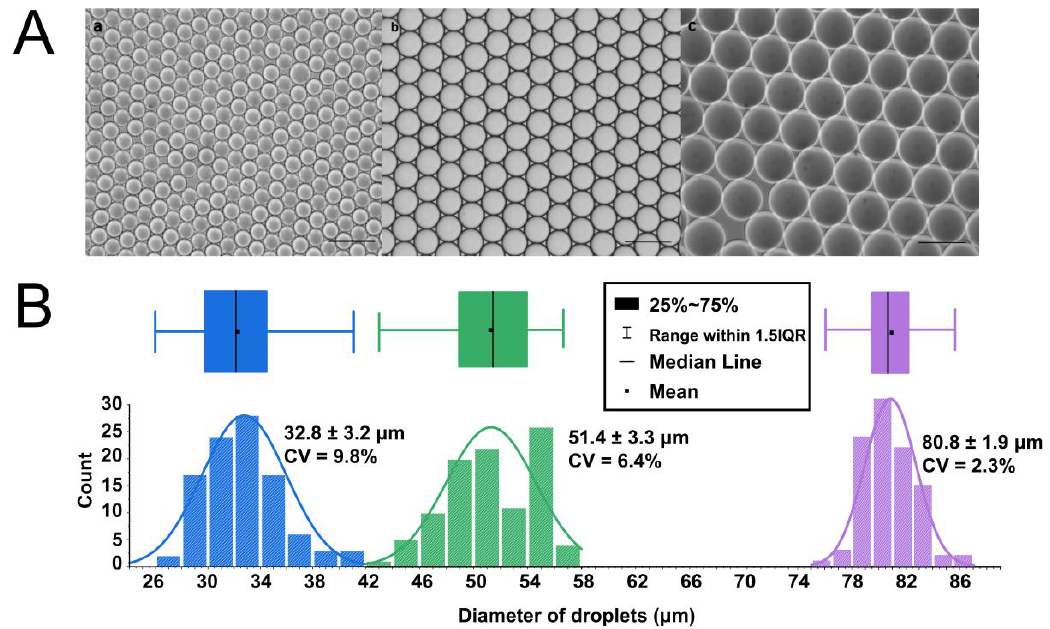
Figure 2. Microfluidic T-junction droplet-generator created uniform and stable droplets. ( A ) The morphology created droplets of three sizes: 32.8 μm, 51.4 μm, and 80.8 μm. Scale bar = 100 μm. ( B ) Plots of size distribution of droplets generated by the microfluidic chip. The limits of the box refer to the 25th and 75th percentiles, the cross line is the mean value, the black square is the median value, and the whiskers extend to 1.5 times the interquartile range (IQR). For each measurement, 100 droplets were counted.